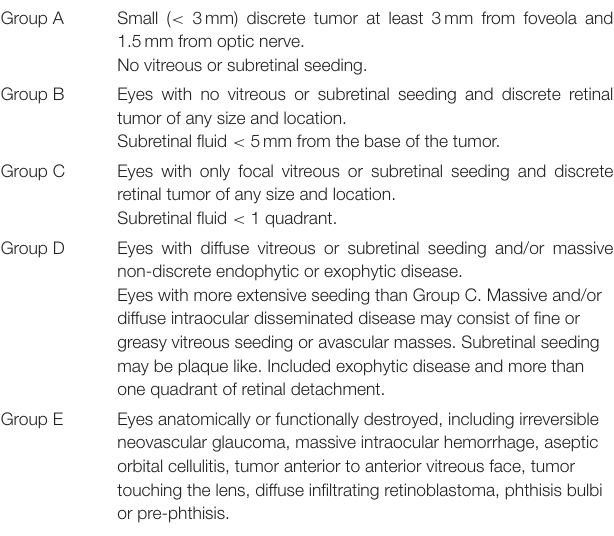
TABLE 1 | International intraocular retinoblastoma classification